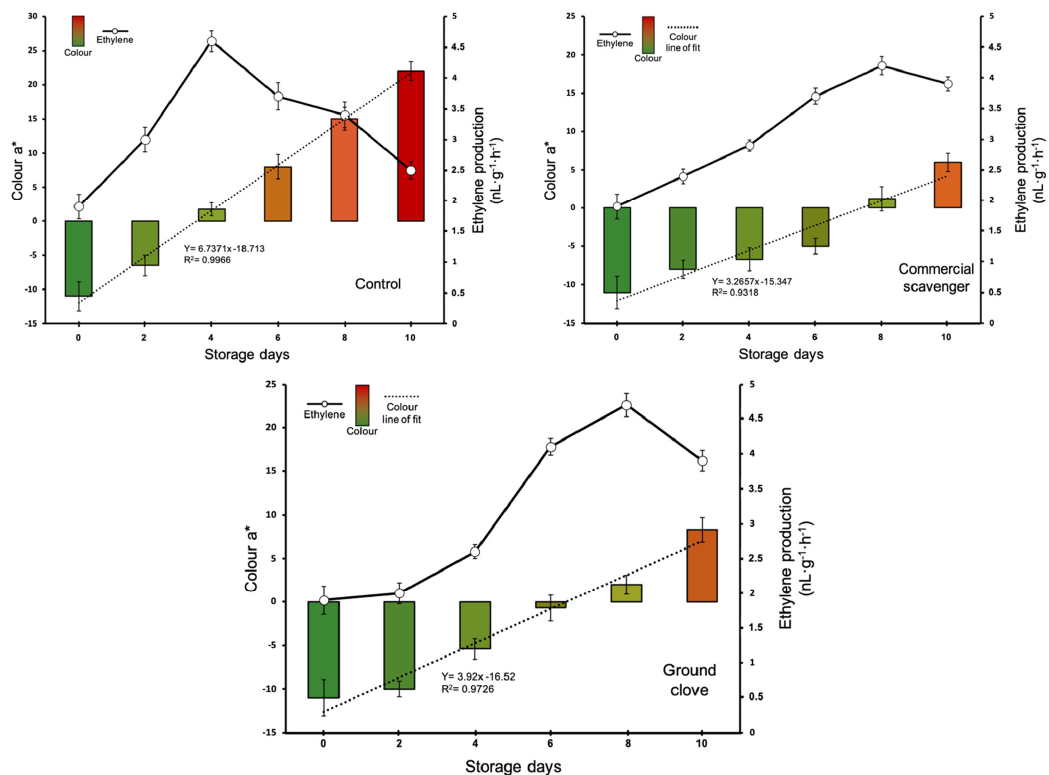
Figure 2. Evolution of the ethylene production rate and color (parameter a*) for Raf tomatoes packaged and not packaged (control) with the commercial scavenger or ground clove. Vertical bars show the standard error (SE) ( n = 15).